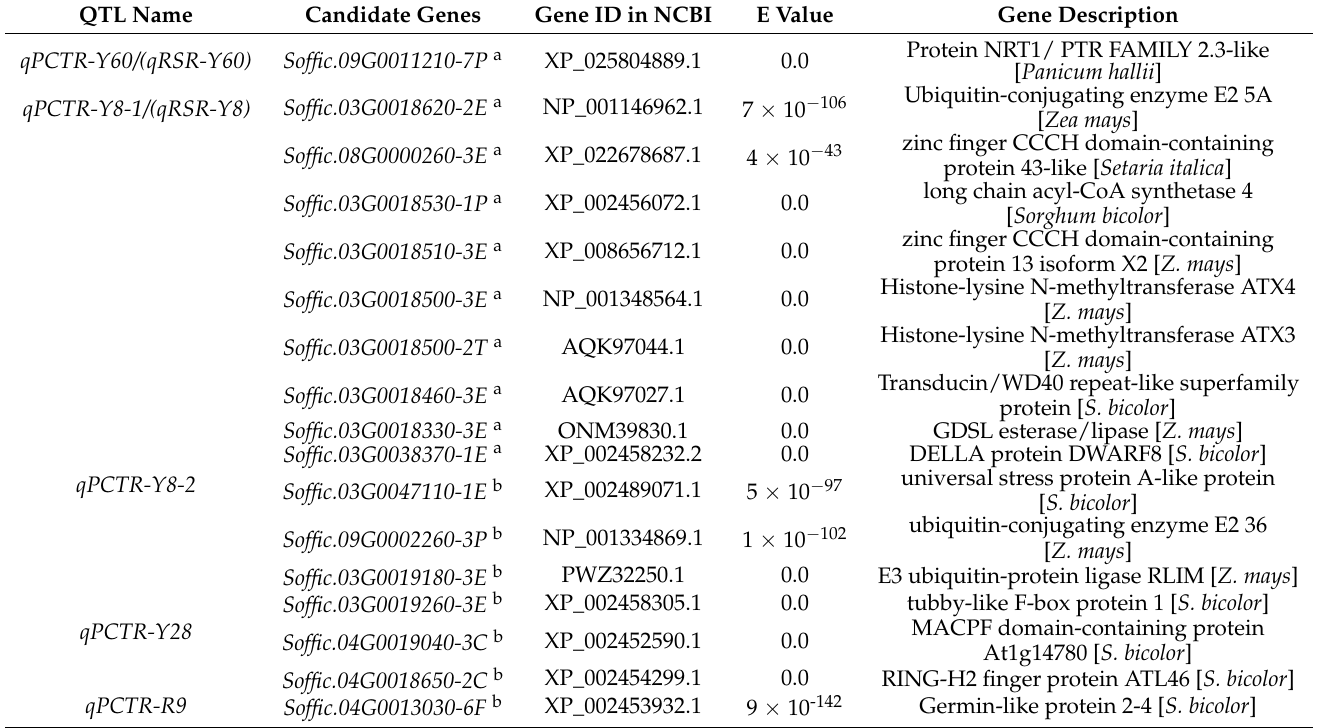
Table 5. Functional annotation of the candidate genes related to sugarcane tillering and